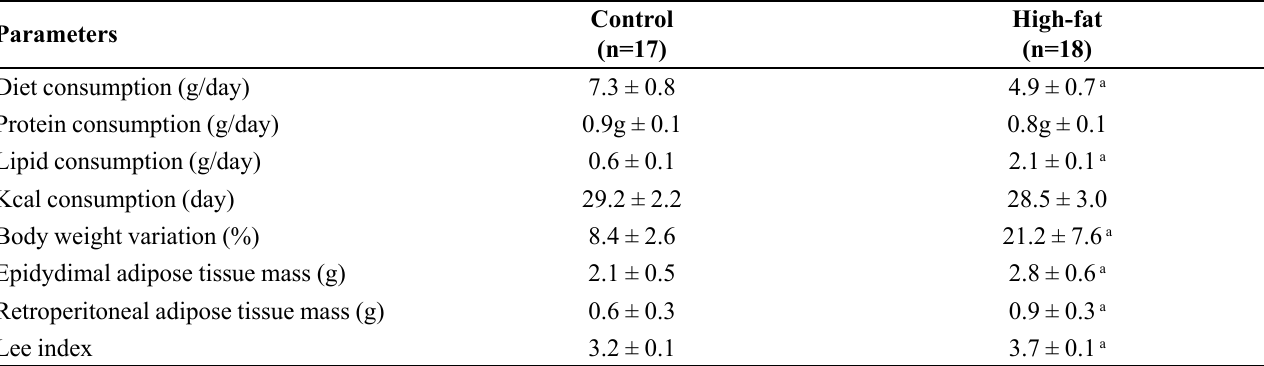
TABLE II - Diet consumption, lipid and protein intake, body weight variation e lipid profile of the control group and high-fat group of Swiss Webster